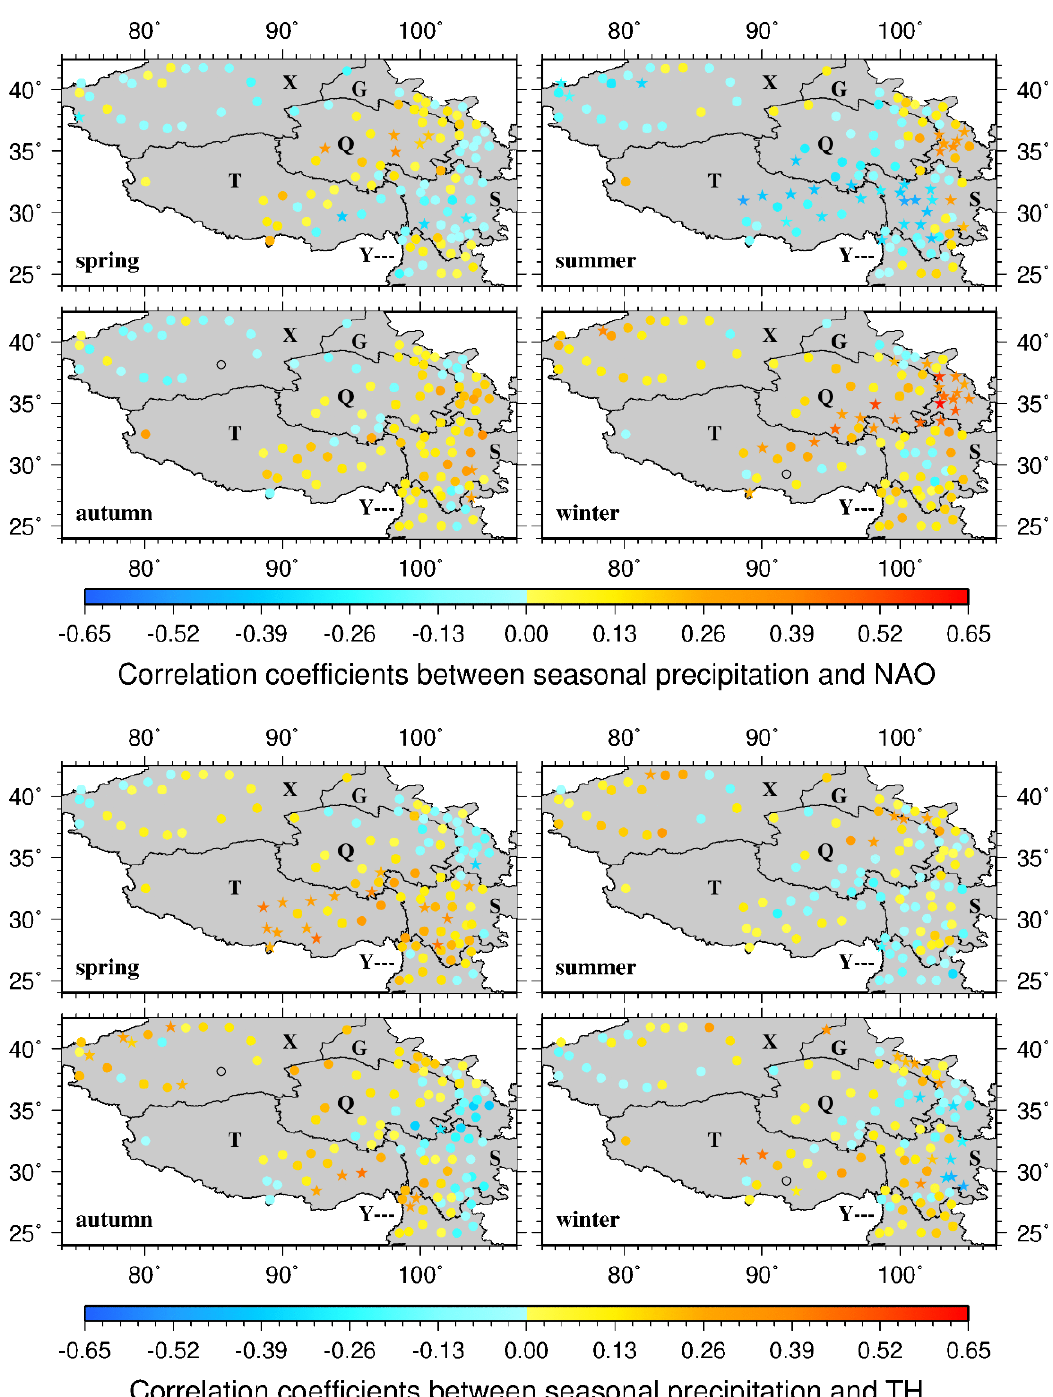
Figure 10. Spatial distributions of correlation coefficients between monthly precipitation and NAO and TH. Stars represent statistically significant trends ( p < 0.05). Open circles denote zero correlations.